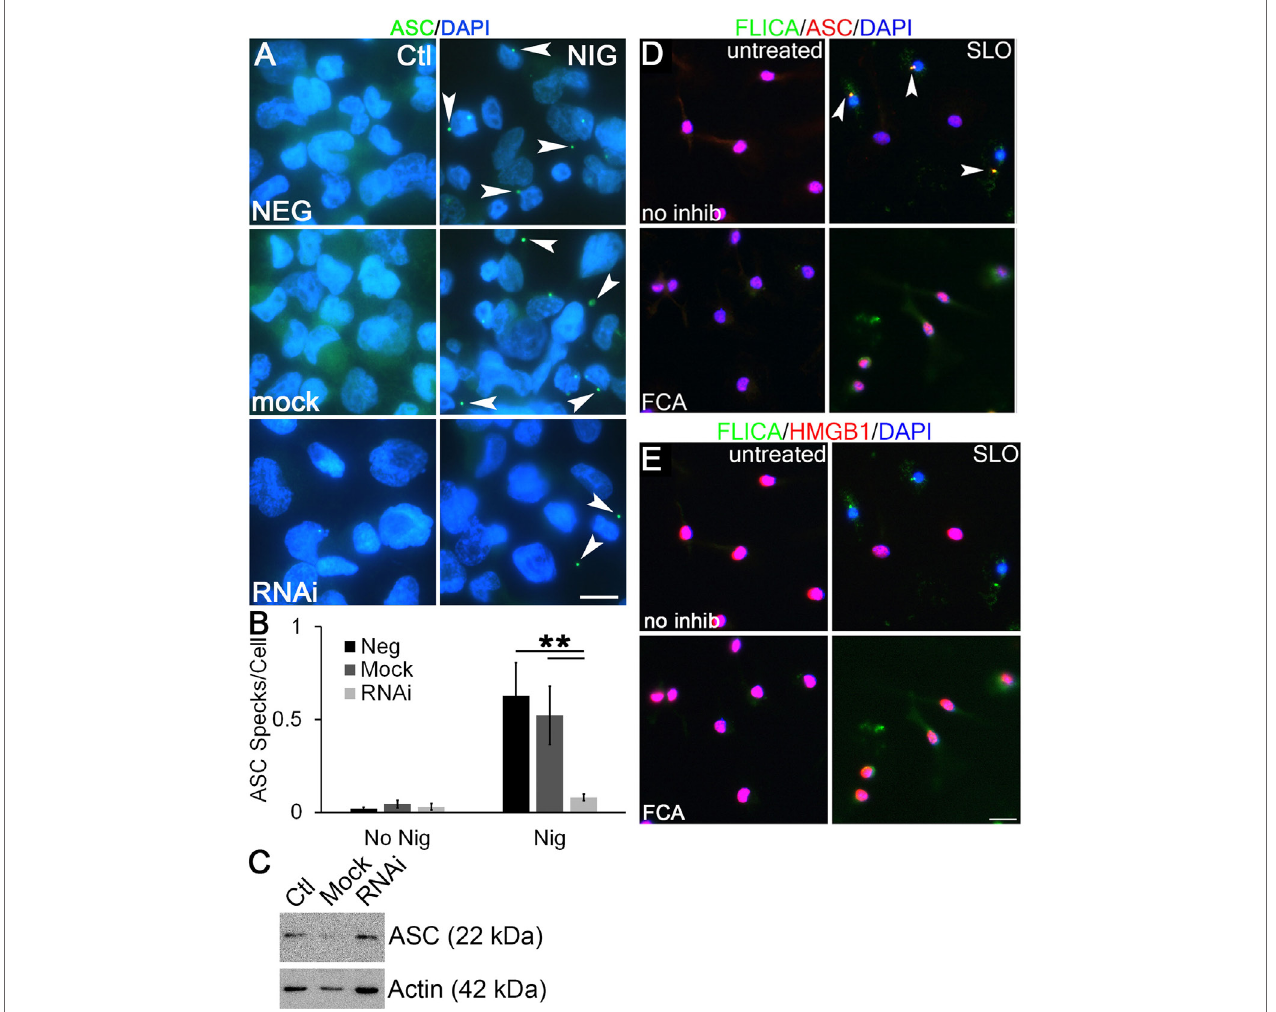
FigUre 8 | Dnase1l3 promotes apoptosis-associated speck-like protein containing a caspase activation and recruitment domain (asc) release from the nucleus . (a,B) THP1 cells were transfected with nothing, mock, or Dnase1L3 siRNA, then phorbol 12-myristate 13-acetate (PMA) differentiated for 2 days, treated with or without 20 µM nigericin for 30 min, fixed, and stained for ASC (green) and DAPI (blue). (a) Representative micrographs show speck formation (arrowheads). (B) ASC specks were quantitated using ImageJ and normalized to the total number of cells. (c) THP1 cells were transfected with nothing, mock, or Dnase1L3 siRNA, then PMA differentiated for 2 days and lysed in SDS sample buffer. Proteins were resolved by SDS-PAGE, transferred to nitrocellulose, and probed with anti-ASC and anti-actin. (D,e) Lipopolysaccharide-primed BMDM were treated with fmoc- d -cyclohexylalanine (FCA) for 30 min followed by challenge with streptolysin O (SLO) in the presence of FLICA (green) for 1 h, fixed, and stained with anti-ASC [ (D) , red] and anti-high-mobility group box 1 protein (HMGB1) Abs [ (e) , red] and DAPI (blue). FLICA/ASC specks are shown by arrowheads. The graph is mean ± SEM of three independent experiments, immunoblot representative of four, and micrographs representative of three (a) or four (D,e) independent experiments. Scale bar = 10 µm (a) or 20 µm (D,e) . ** p <